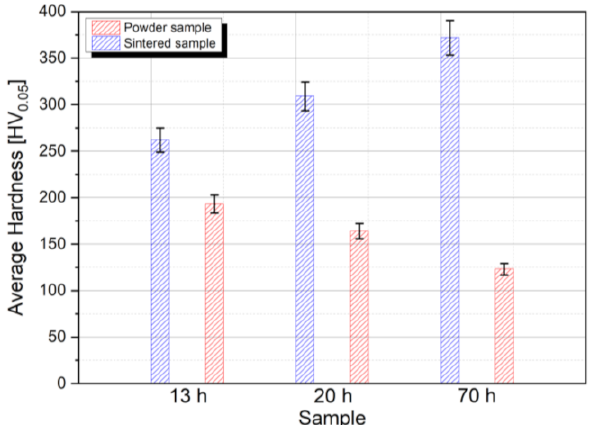
Figure 11. Average hardness and particle size for Mg-Zn-Ca-Pr samples after 13, 20, and 70 h of milling, for both powder and sintered